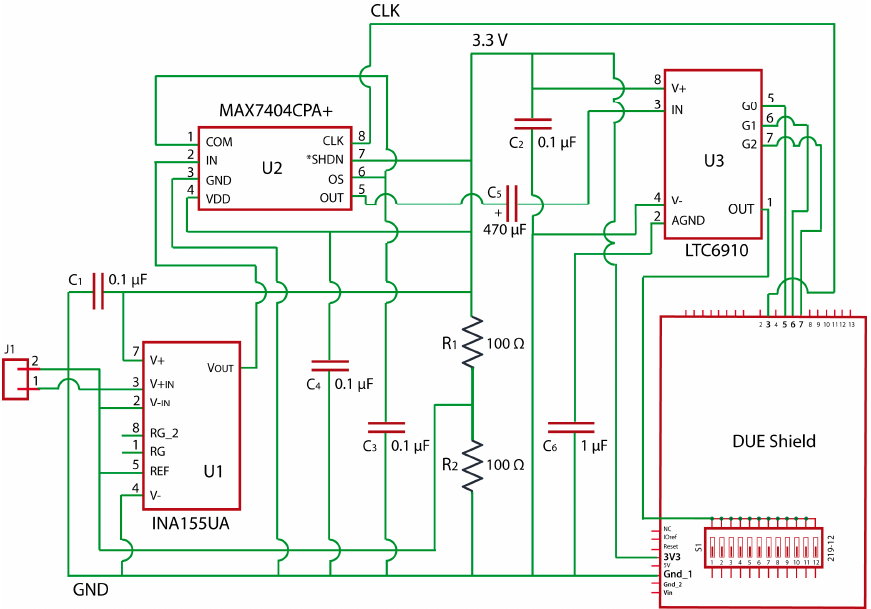
Figure 3. Schematic circuit of the Signal Conditioning Circuit (SCC) (made with Eagle free software).